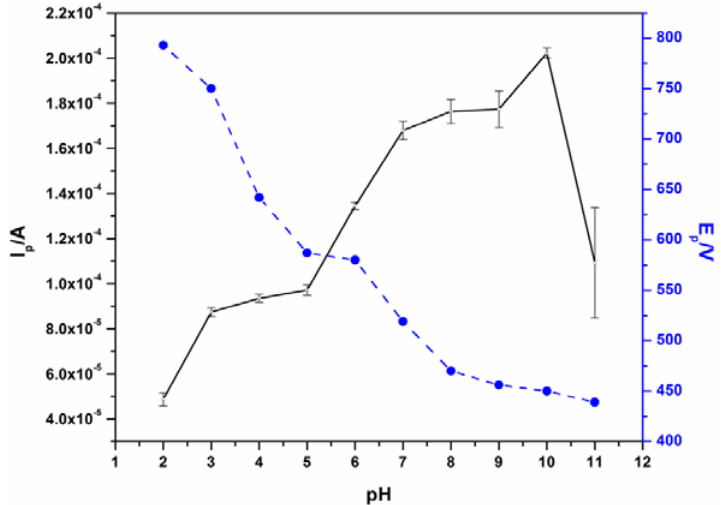
Figure 3. Effect of pH on the peak current (solid line) and peak potential (dotted line) on 30 µM BPA using SWV. The pre-concentration time for all pH optimisation measurements was 5